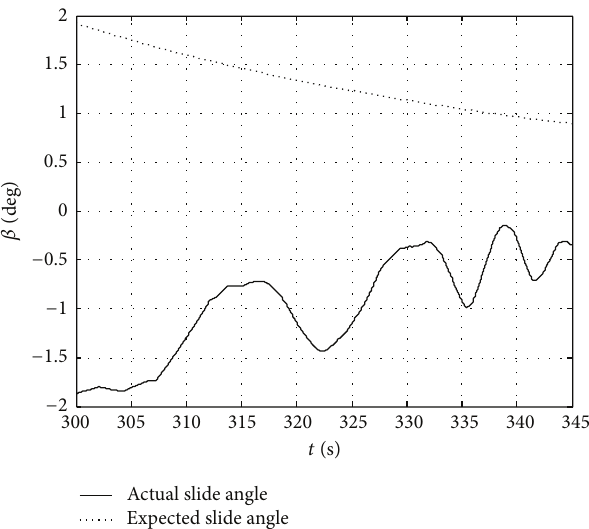
Figure 18: Simulation result of trajectory deflection angle.